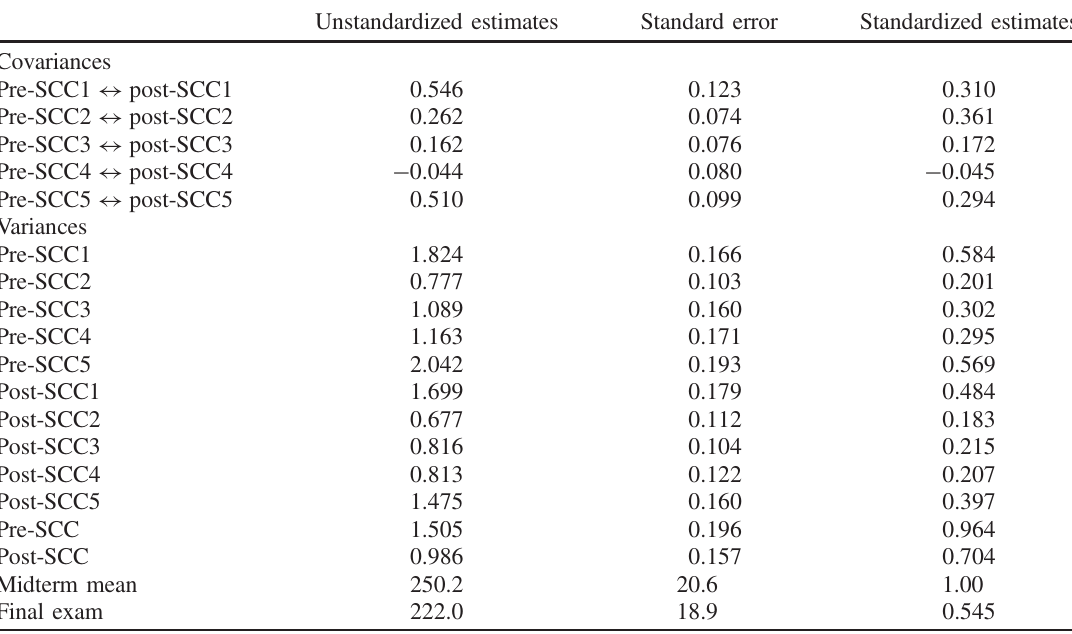
TABLE VIII. SEM estimates of model covariances and variances. Standardized estimates are standardized for all variables.